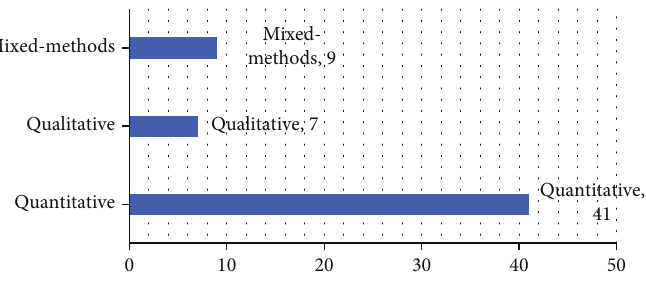
Figure 7: No. of papers per study design.